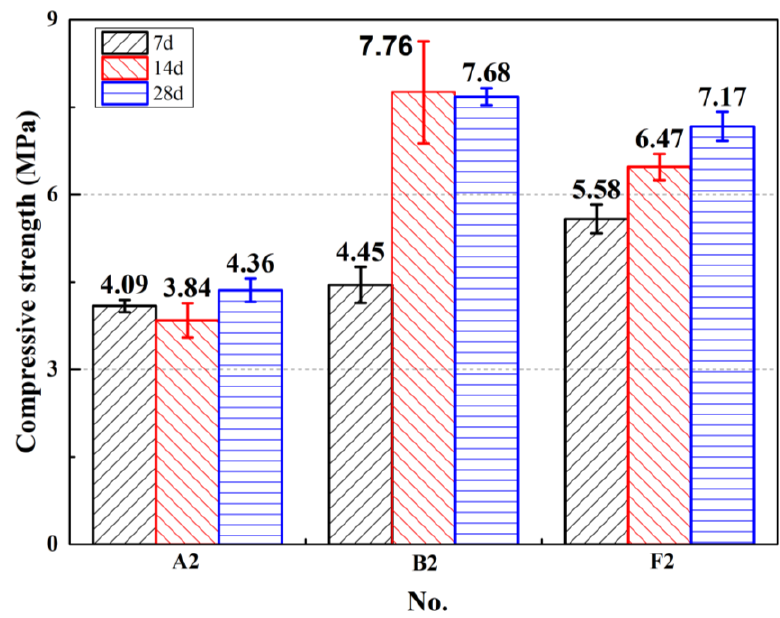
Figure 4. Compressive strength of specimens when water-to-binder ratio is 2.